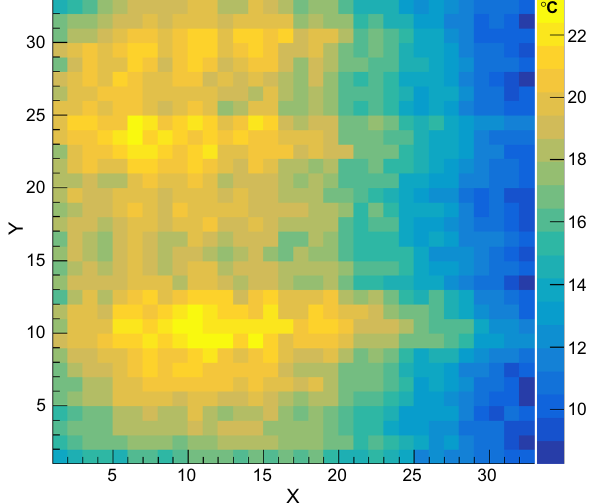
Fig. 20 Two-dimensional temperature distribution of 32 × 32 SiPMs in the camera. The air inlet is on the right side, and the air outlet is on the left side